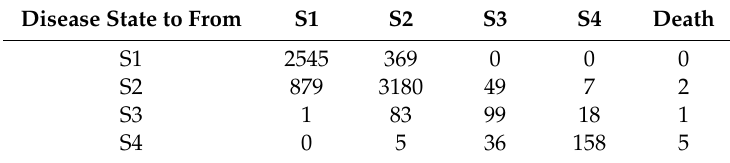
Table 3. Transitions of disease states observed during the first five days in PROGRESS. Disease State to From S1